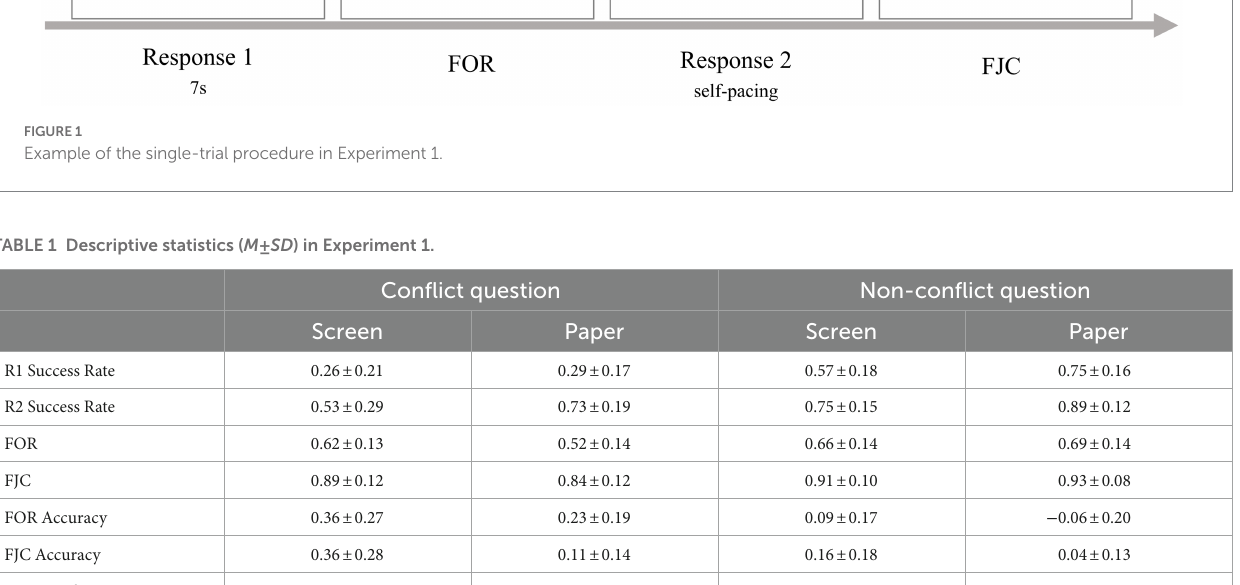
FIGURE 1 Example of the single-trial procedure in Experiment 1.